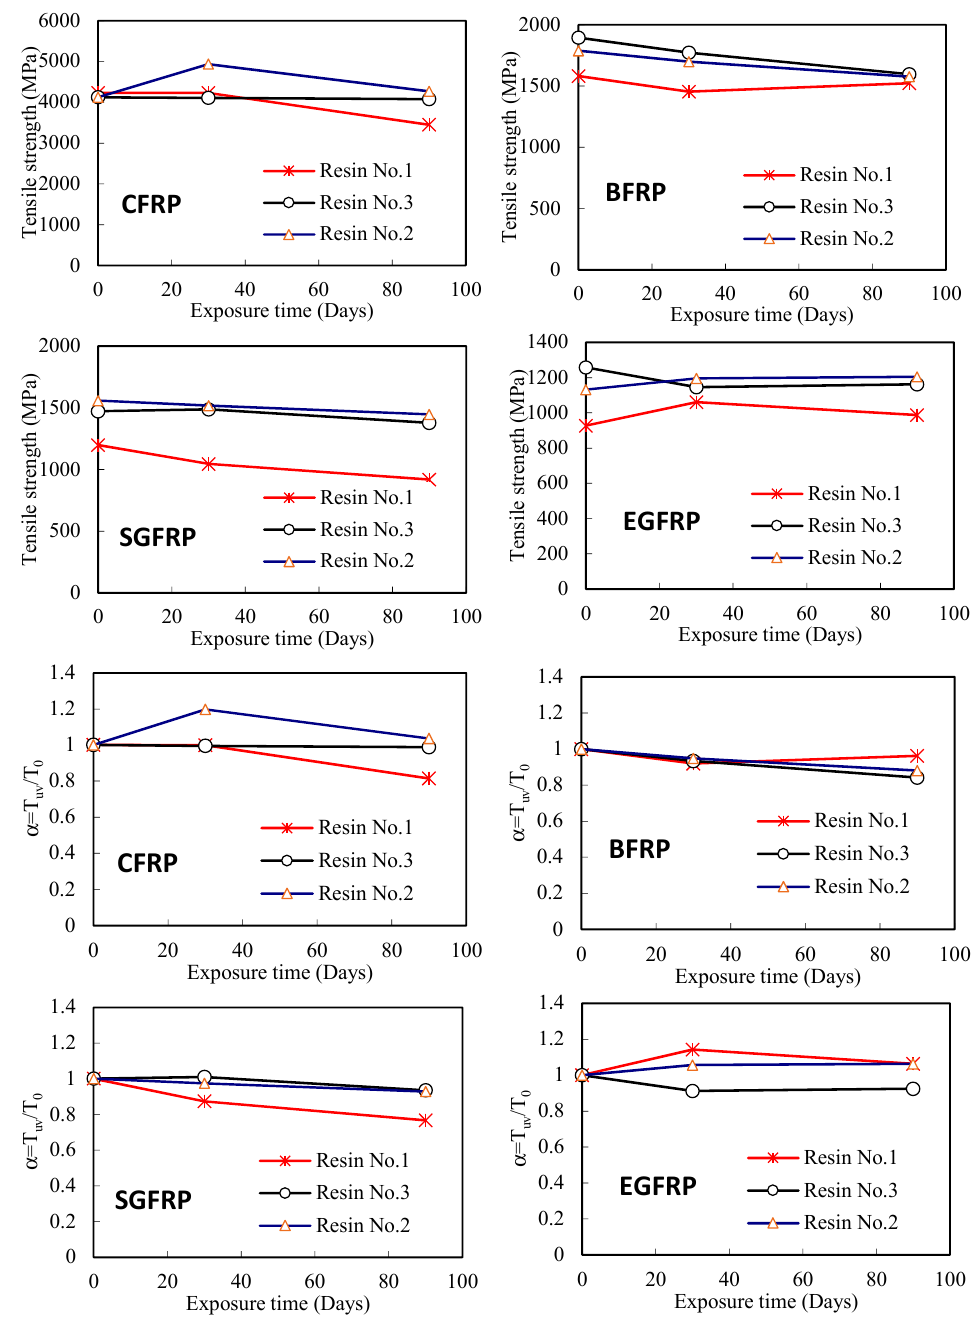
Figure 10. Effect of UV exposure on the ultimate tensile strength of FRP sheets using different resins (one layer).